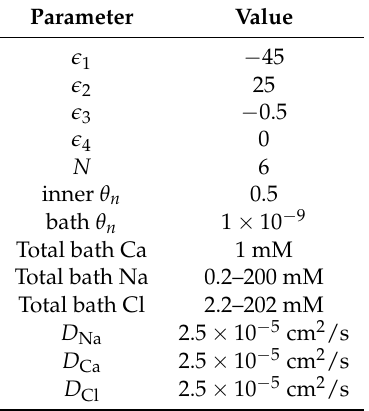
Table 1. Parameters that do not vary between sets of experiments.